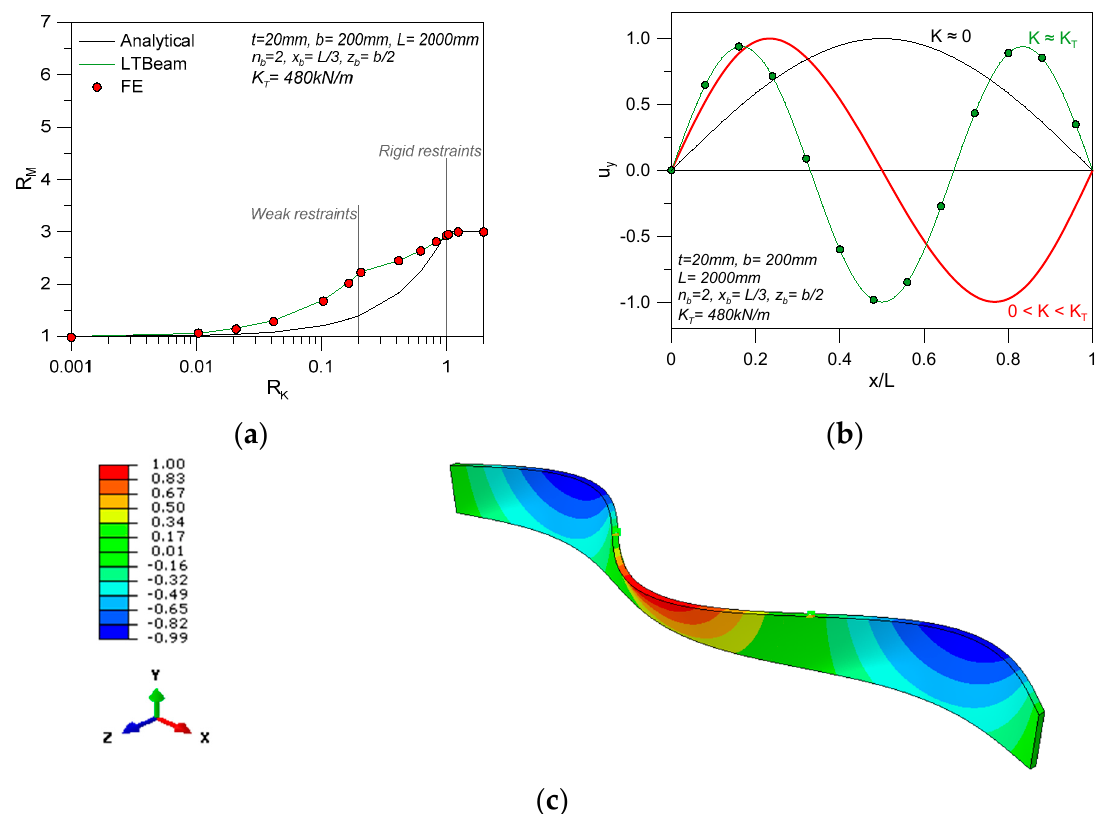
Figure 18. Comparative LTB calculations for LR glass beams with n b = 2 discrete lateral restraints (with K = var): effects on ( a ) theoretical buckling resistance and critical deformed shapes (from ( b ) LTBeam or ( c ) ABAQUS respectively).